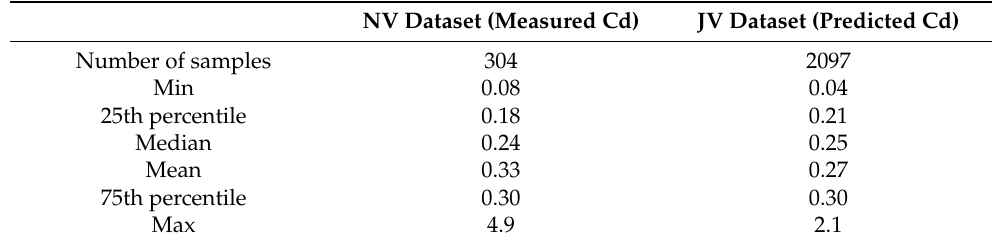
Figure 2. ( a ) Cross-validation of the model for predicting cadmium (Cd) concentration in soil from portable X-ray fluorescence (PXRF) measurements and ( b ) enlarged image of the range of 0–1 mg kg − 1 . Five folds were used on 304 samples with laboratory-analyzed Cd concentrations. The Nash–Sutcliffe model efficiency coefficient is displayed (E) as well as the mean absolute error (MAE). Table 4. Descriptive statistics on laboratory-analyzed cadmium (Cd) concentrations in the calibration NV dataset and those predicted by the portable X-ray fluorescence (PXRF) model on the JV dataset (mg kg −1 ).